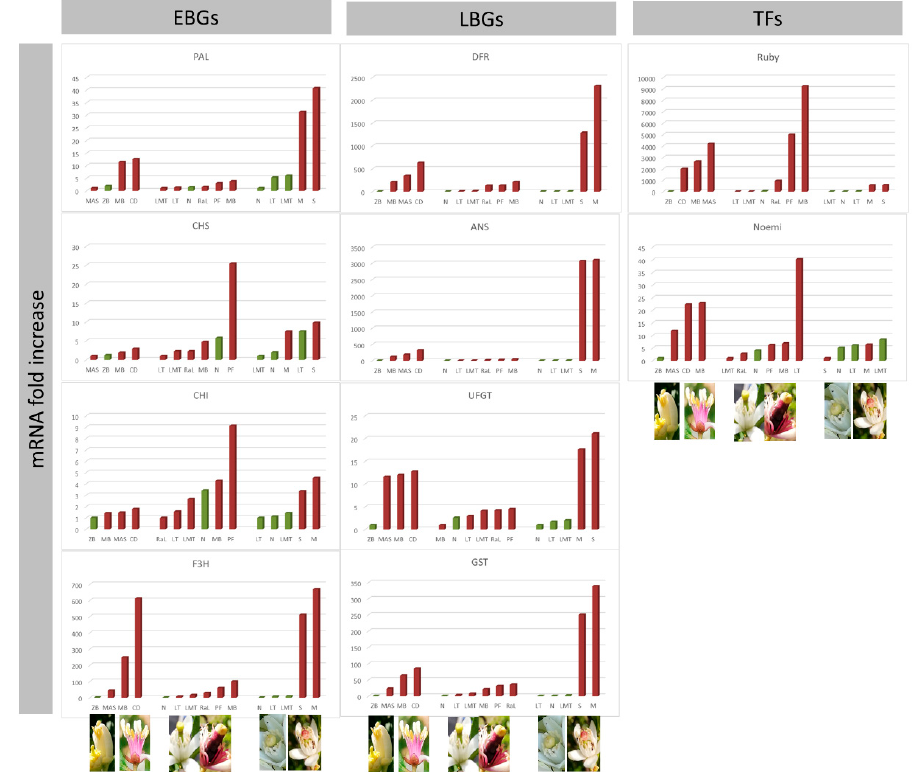
Figure 11. qRT-PCR expression data for all structural genes separated into Early Biosynthetic Genes (EBGs) and Late Biosynthetic Genes (LBGs) and Transcription Factors (TFs) in stamen, style, and stigma. The expression levels were calculated as mRNA-fold increases. Each accession is indicated by a